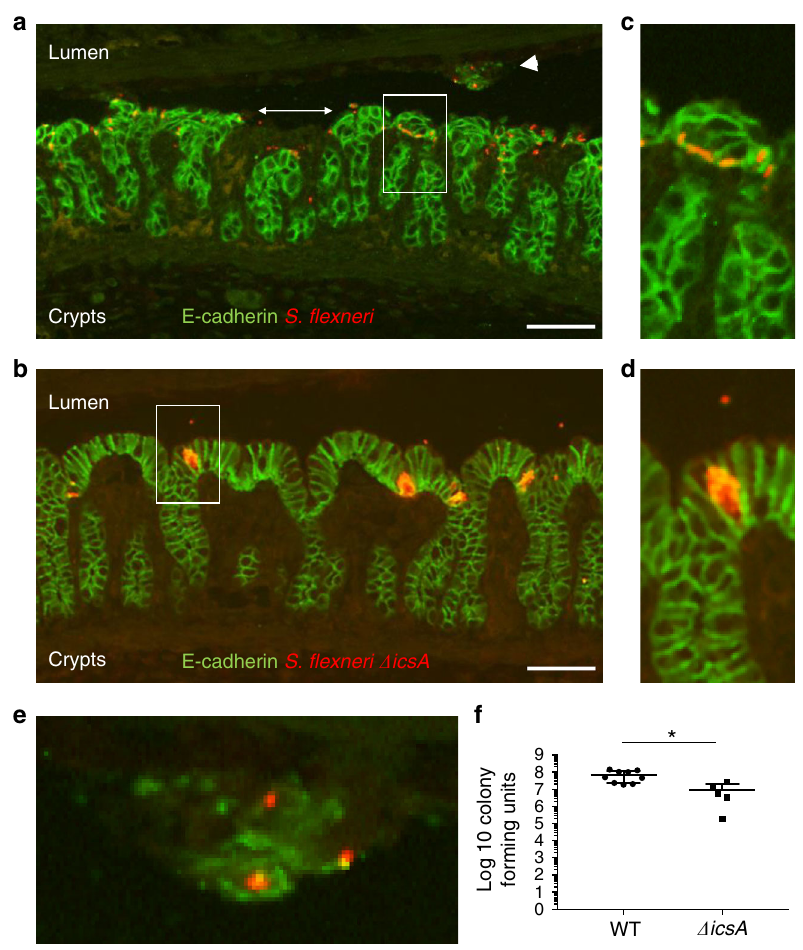
Fig. 5 Shigella fl exneri spreads from cell to cell in an IcsA-dependent manner. a , b Representative images of colon sections infected with S. fl exneri ( a ) and the Δ icsA mutant ( b ). Scale bars, 50 μ m. E-cadherin, green; S. fl exneri , red. c , d Zoom-in on the boxed area in a , b , respectively. e Zoom-in on the area indicated by the arrowhead in a . f Graph showing counts of colony-forming units in the distal colon of animals infected with S. fl exneri (wild-type (WT)) or the Δ icsA mutant. Statistical analysis: unpaired t test. Δ icsA vs. S. fl exneri (WT), * P < 0.05. Source data are provided as a Source Data fi